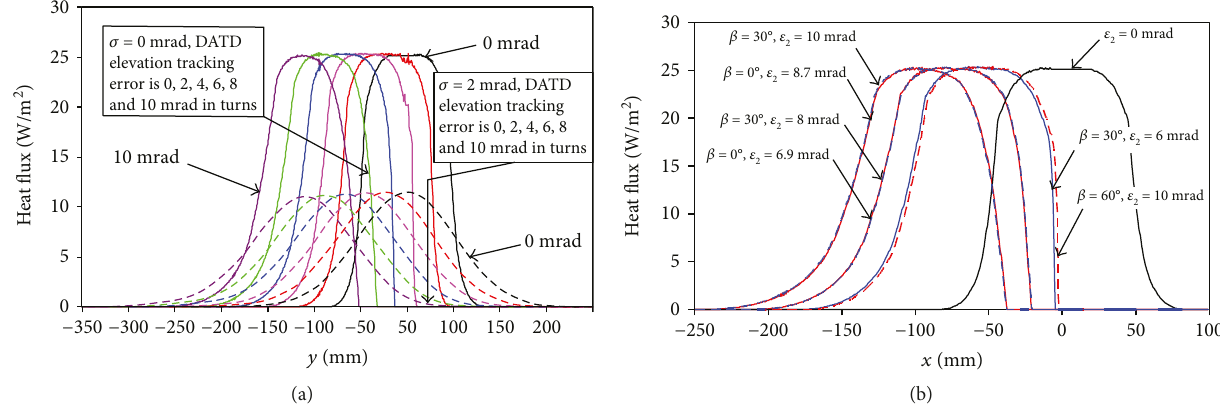
Figure 7: In fl uence of the EATD tracking error on the fl ux distribution of the focal